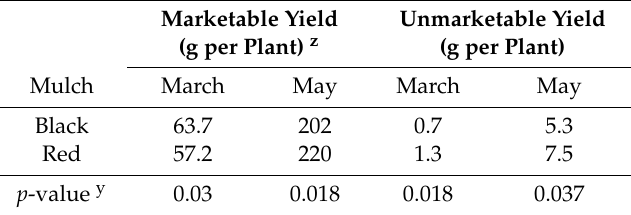
Table 4. Monthly marketable and unmarketable yields of strawberry cultivars a ff ected by plastic mulch type grown in a high tunnel in Starkville, Mississippi from November 2017 to June 2018.